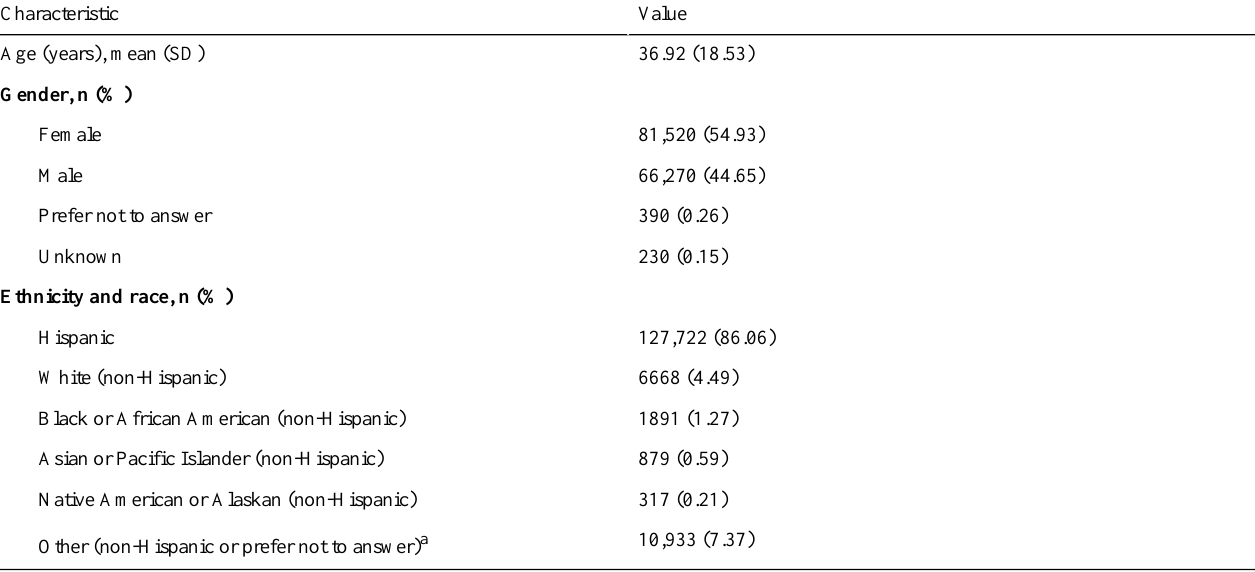
Table 1. Demographic characteristics of the population from the greater El Paso area based on the COVID-19 tests submitted to the Dascena COVID-19 Laboratory between September 15, 2020, and January 11, 2021.